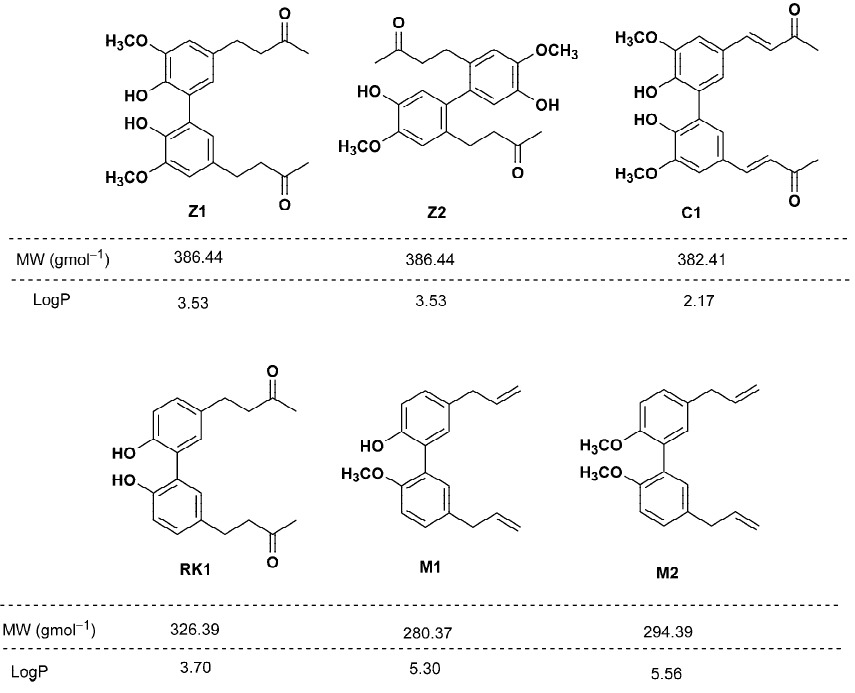
Figure 12. Structural formulas of tested compounds .